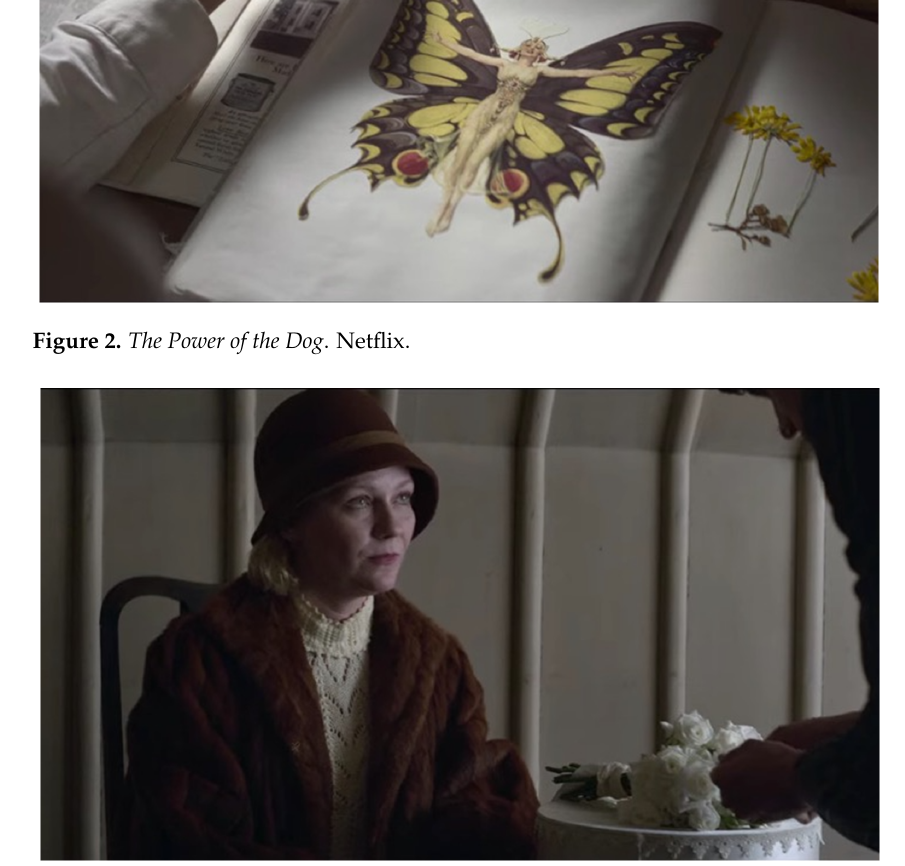
Figure 3. The Power of the Dog . Netflix.